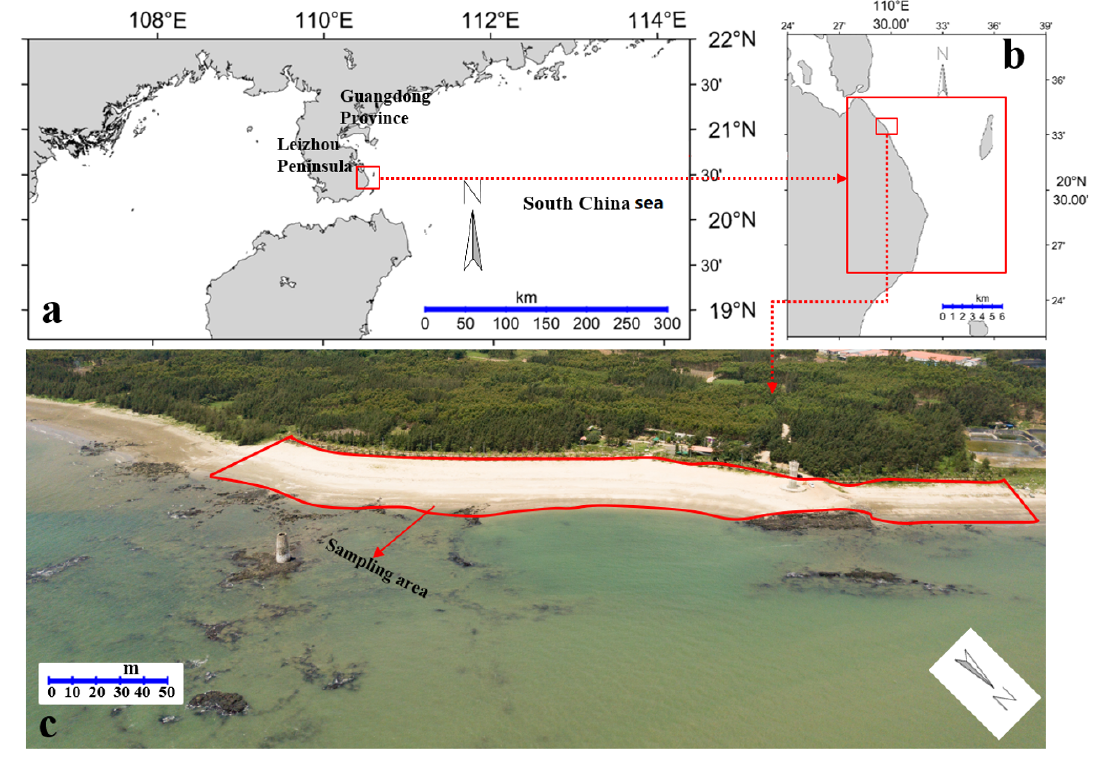
Figure 1. ( a ) The geographical location of the study area at a large scale; ( b ) the geographical location of the study area at a small scale; ( c ) a photo of the field site of choice taken using UAV photography technology. The field site is a typical sandy beach used to monitor beach responses to